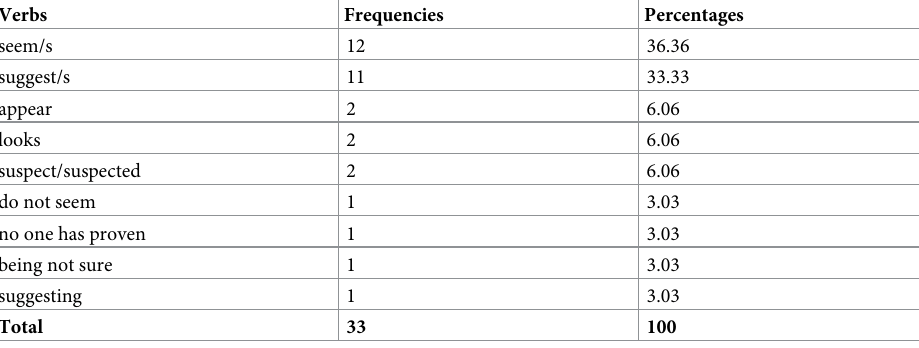
Table 18. Frequencies and percentages of verbs.